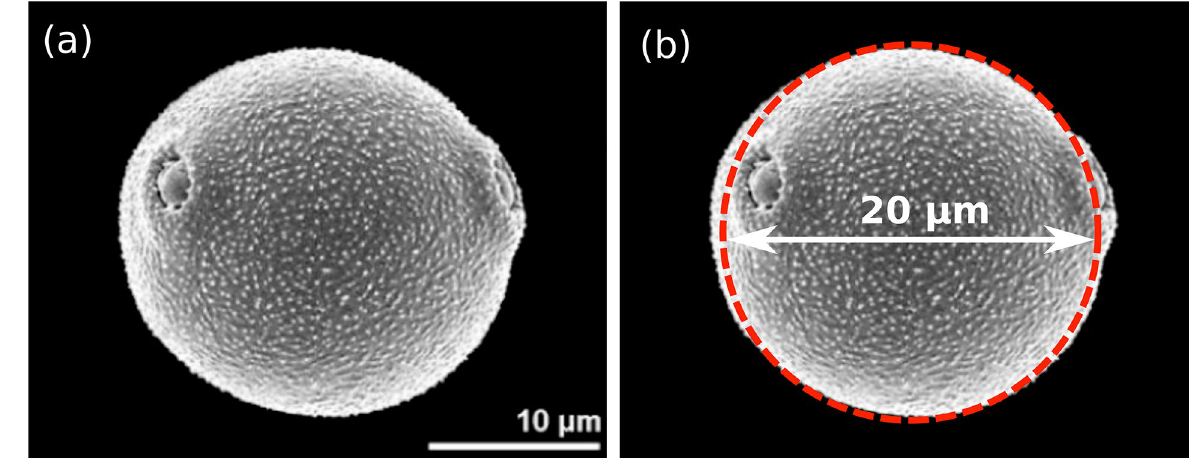
Figure 1. Pollen grain microscopy. ( a ) Birch ( Betula pendula ) pollen grain (source: Halbritter et al. 10 ); ( b ) showing an approximated spherical shell of 20 µ m diameter (red color dashed-curve) used in the present computational